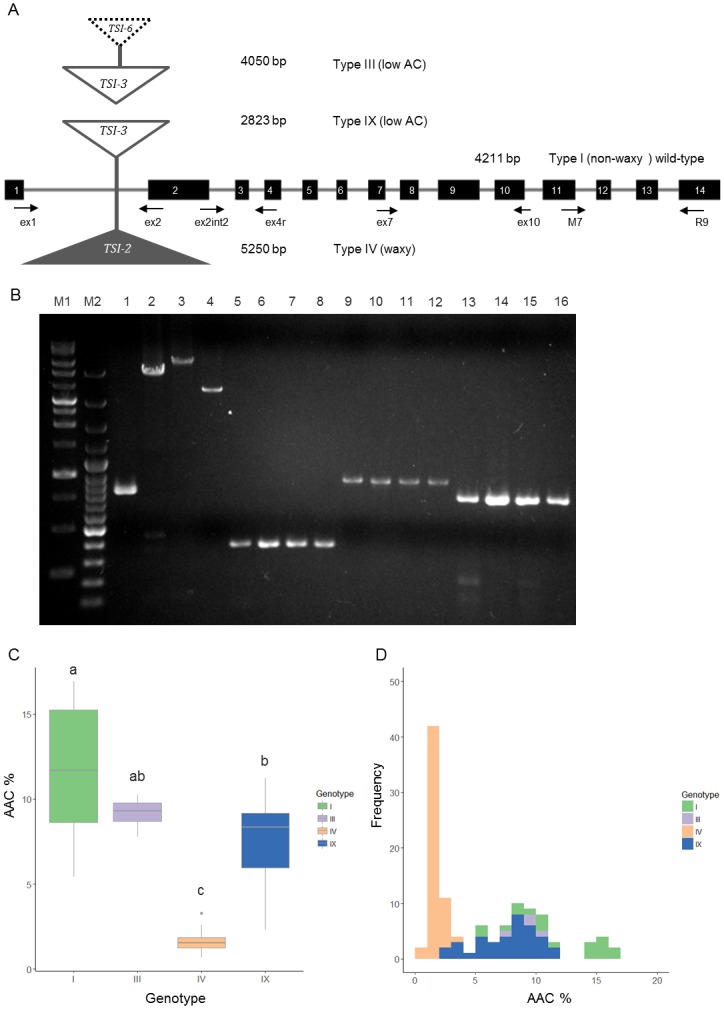
Assessment of Wx genotypes and phenotypes.(A) Schematic of the foxtail millet Wx gene. The positions of primer sets used to analyze genotypes are depicted, and primer sequences are listed in S2 Table. (B) PCR amplicons of foxtail millet Wx genotypes. Primer combinations, ex1 and ex2 (1–4), ex2int2 and ex4r (5–8), ex7 and ex10 (9–12), M7 and R9 (13–16), are indicated at the top of each the figure. M1 and M2 indicates 1 kb DNA ladder (DM3100 ExcelBand) and 100 bp DNA ladder (100 bp DNA ladder plus, GeneTeks BioScience Inc.), respectively. (C-D) The distribution of apparent amylose content (AAC) for each Wx genotype. A total of 114 accessions used for AAC assays were grown in the first crop season of 2015.